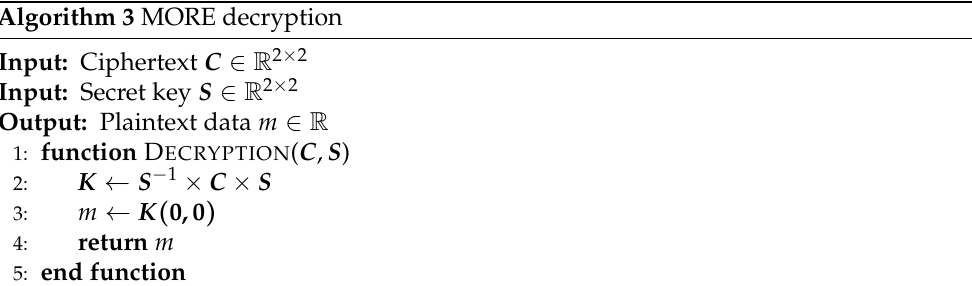
Algorithm 3 MORE